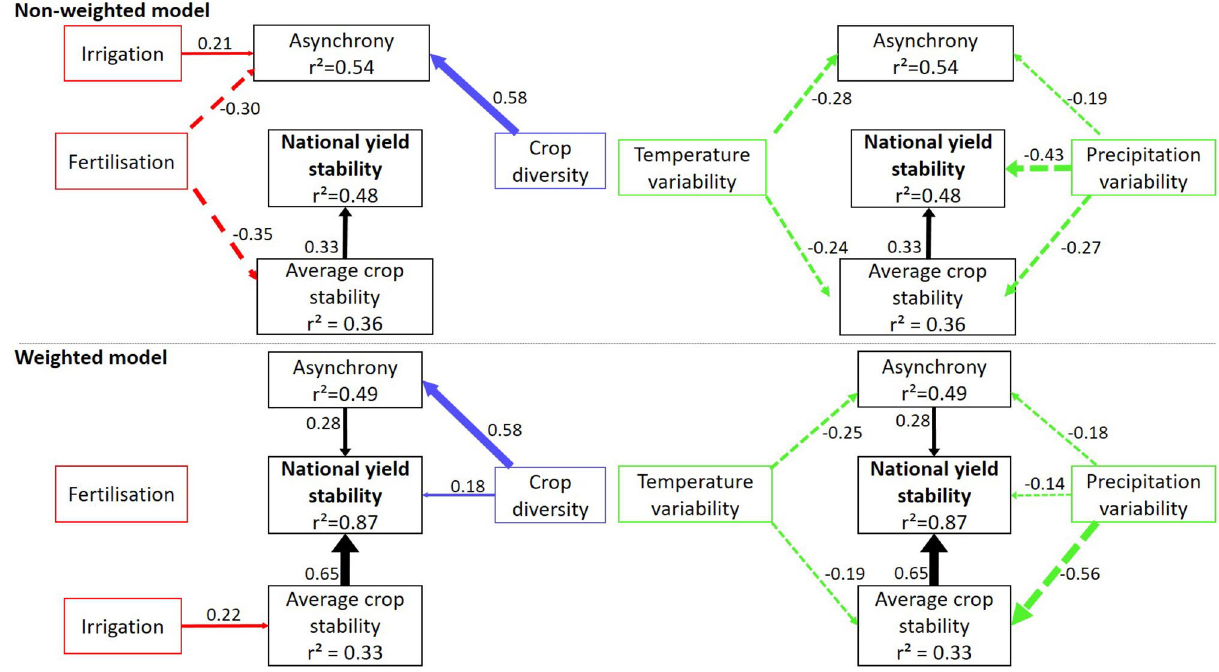
Figure 1. Structural equation model representing the drivers of the stability of national food production. For a seek of clarity, the contribution of agricultural inputs (red path) and crop diversity (blue path) to the stability of national food production are represented separately from the ones of climate variability (green path) [left and right panels, respectively]. Top: Non-weighted model. Crop diversity is quantified by crop richness. Down: Abundance weighted-model. Crop diversity is quantified by the exponential of Shannon diversity index. Asynchrony and average stability are weighted by the proportion of total cropland each crop occupied. The thickness of the arrows indicates the relative contribution of each variable. Plain arrows represent positive relationships while dotted arrows represent negative relationships between two boxes. Only relationships supported by the data ( P > 0.05) are shown. Standardized regressions weights (along arrows) and squared coefficient of regressions (r 2 ) for the fitting model are shown. Test indicates close model-data fit (Fisher’s C = 0.16, P = 0.92 and Fisher’s C = 0.46, P = 0.79 for non-weighted and weighed models, respectively). National yield stability, nitrogen use intensity and the percentage of land equipped for irrigation are